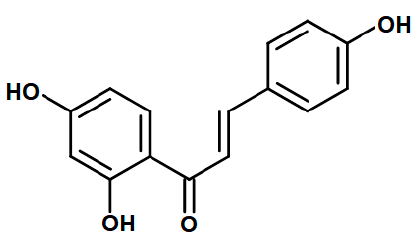
Figure 1. Chemical structure of isoliquiritigenin (IsoLQ).